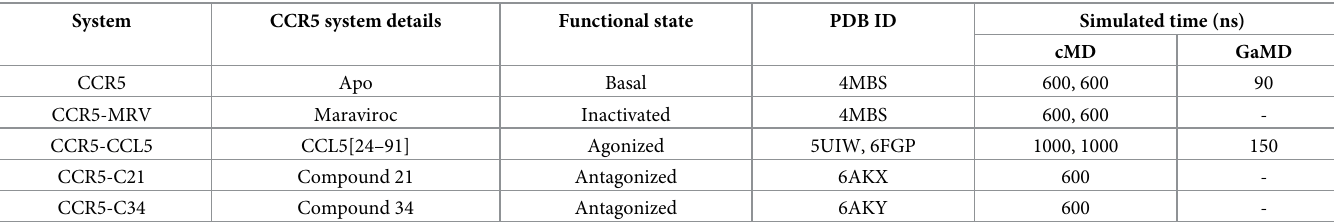
Table 1. Simulated CCR5 systems and PDB IDs employed to build our initial